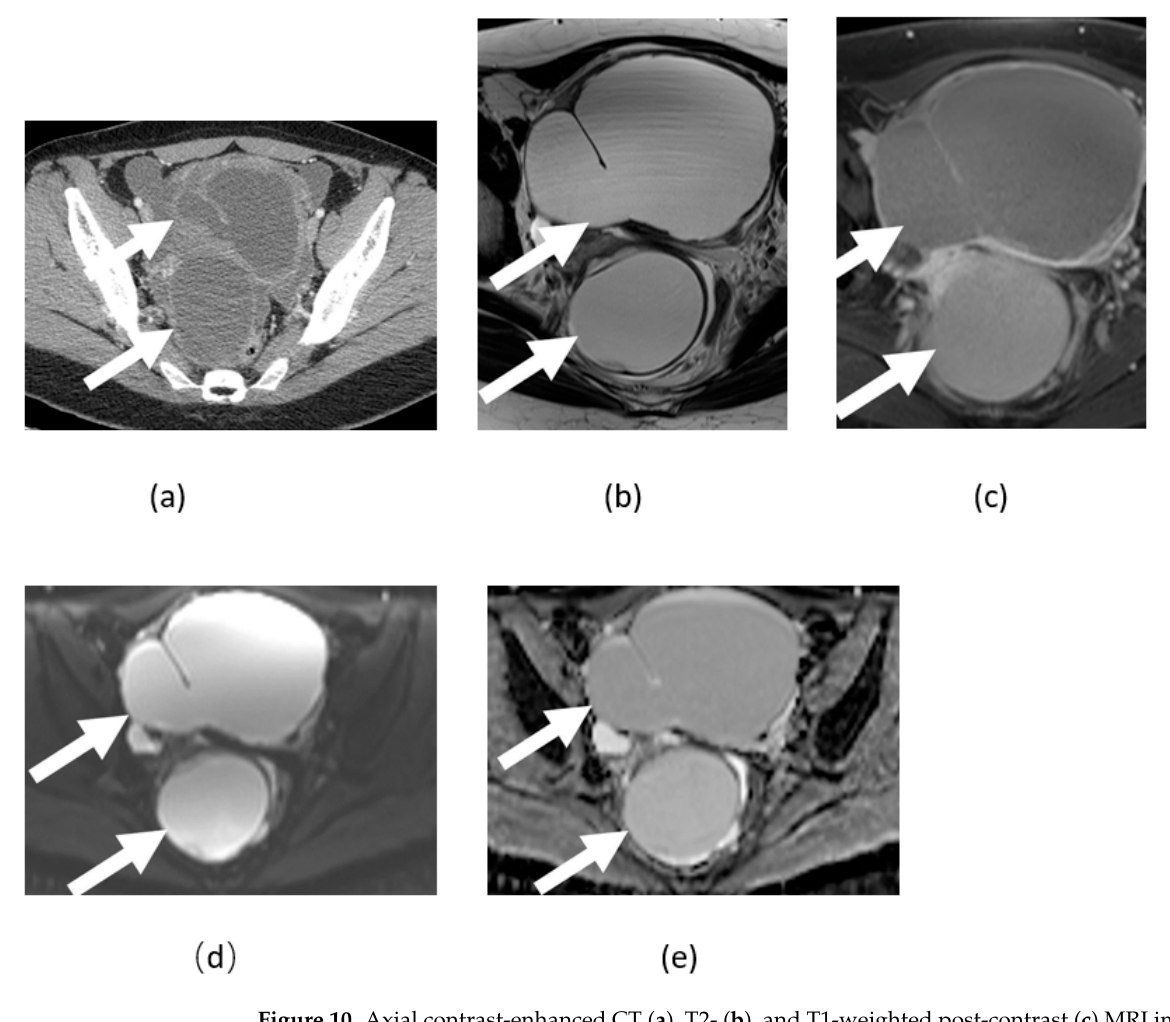
Figure 10. Axial contrast-enhanced CT ( a ), T2- ( b ), and T1-weighted post-contrast ( c ) MRI image of pelvis shows large chronic tubo-ovarian abscess (arrows) without diffusion restriction on axial DWI ( d ) and ADC maps ( e ).